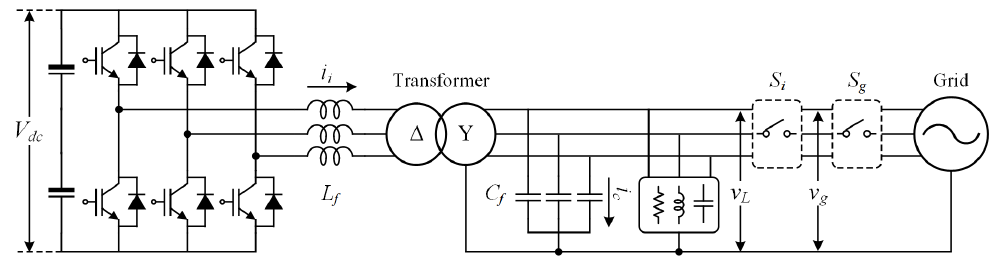
Figure 3. Block diagram of the three-phase